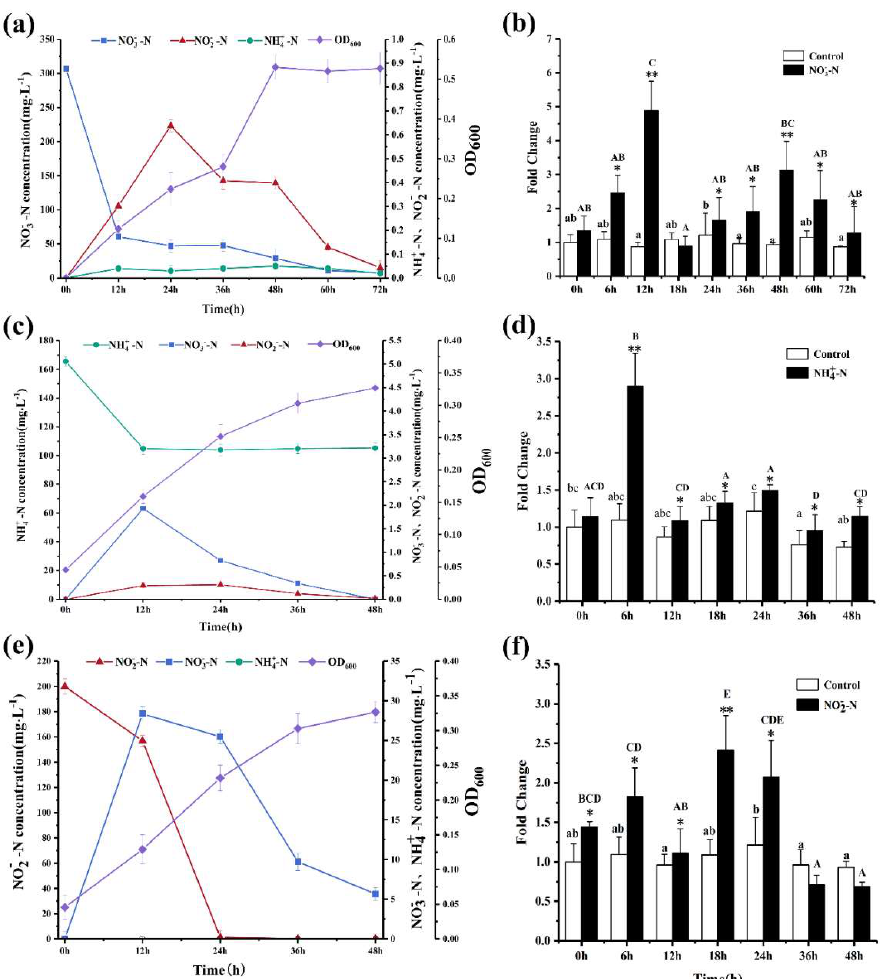
Figure 3. Nitrogen removal efficiency ( a , c , e ) and transcriptional analysis ( b , d , f ) of the nirK gene in denitrification medium (DM)-1, DM-2, and DM-3: ( a , b ) in DM-1 containing 306.9 mg/L of NO 3 -N; (c and d) in DM-2 containing 165.49 mg/L of NH 4+ -N; ( e , f ) in DM-3 containing 200 mg/L of NO 2- -N. All values are presented as the means ± SD (n = 3). The values that are significantly different from the individual controls are present with asterisks (* p < 0.05 and ** p < 0.01). Values with different capital (lowercase) letters are significant differences among the experimental group (control group).